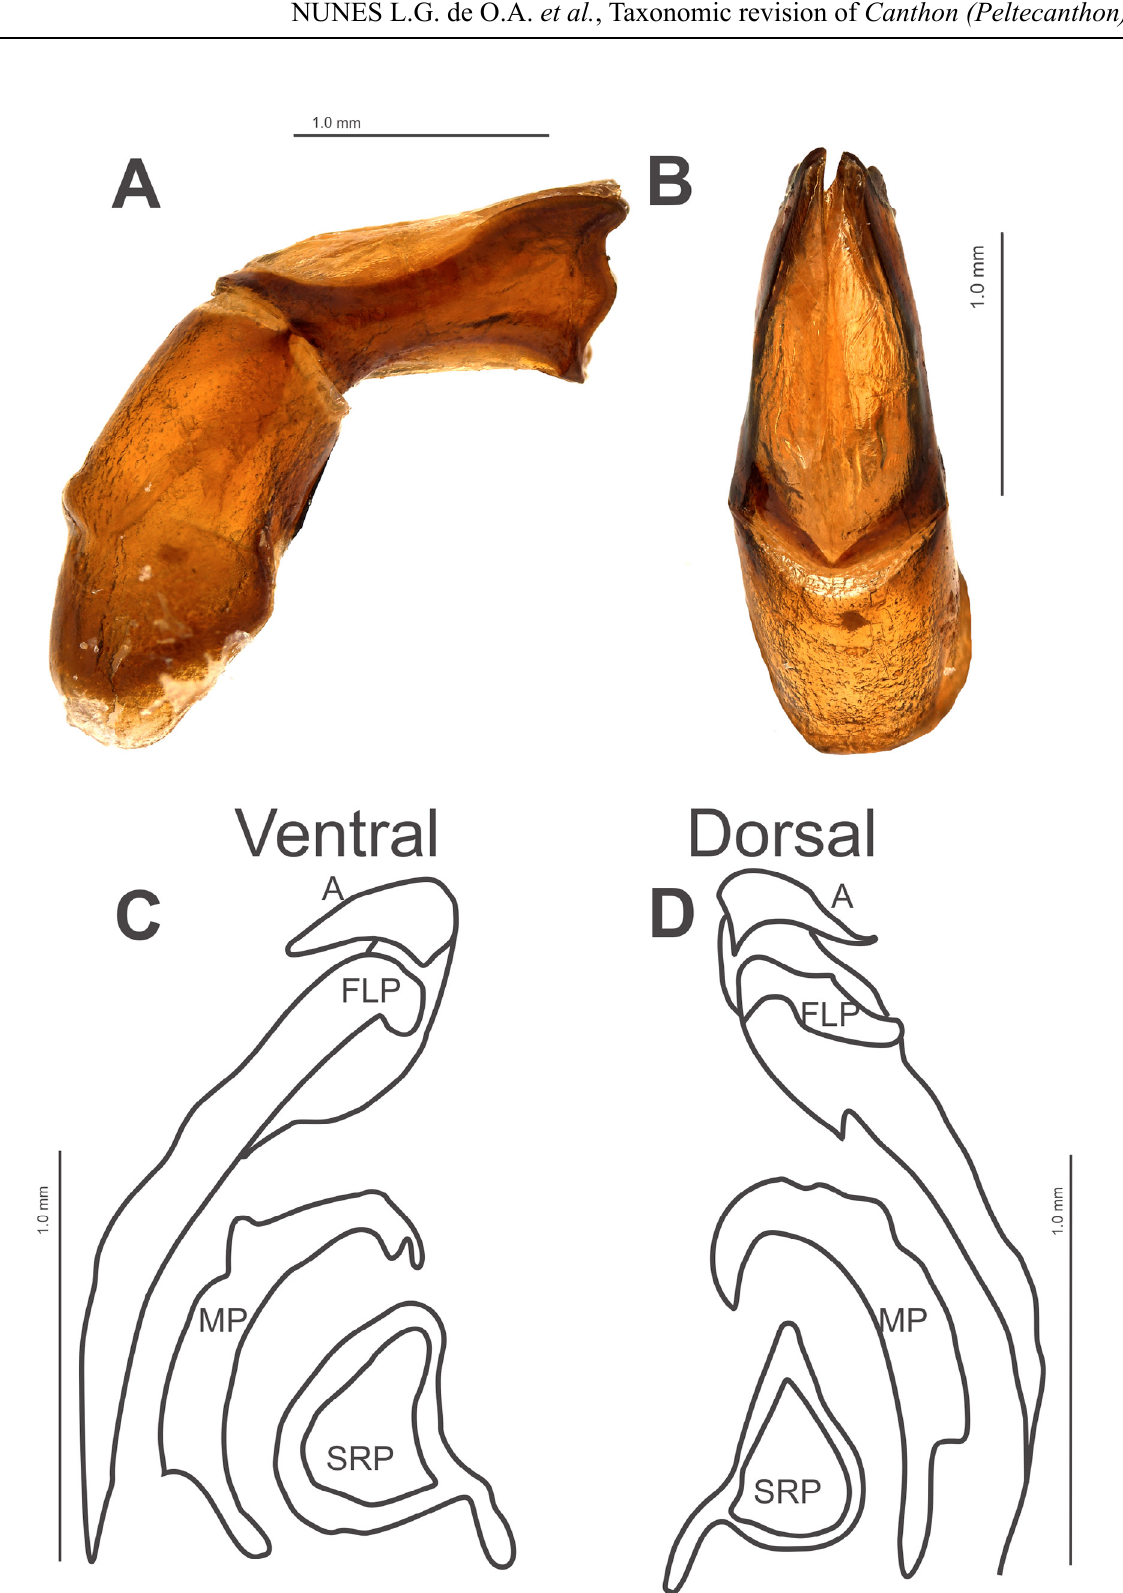
Fig. 6. Canthon ( Peltecanthon ) splendidus Schmidt, 1922, ♂, Rio de Janeiro, Marechal Floriano (CEMT). A . Parameres lateral view. B . Parameres dorsal view. C . Internal sac ventral view. D . Internal sac dorsal view. Abbreviations: see Material and